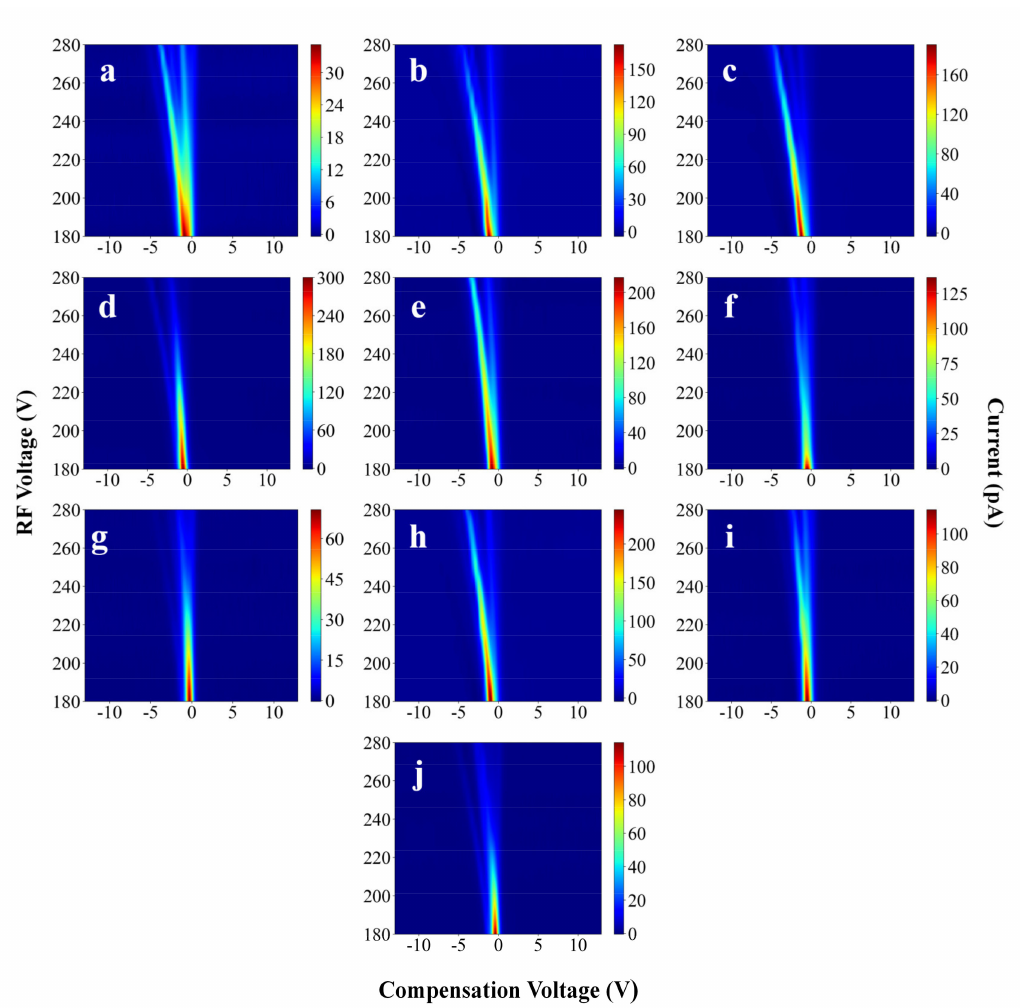
Figure 4. FAIMS spectra of several mixtures: ( a ) ethanol + ethyl acetate, ( b ) ethanol + acetone, ( c ) ethanol + acetone + ethyl acetate, ( d ) acetone + ethyl acetate, ( e ) ethanol + 4-methyl-2-pentanone, ( f ) ethanol + 4-methyl-2-pentanone + ethyl acetate, ( g ) 4-methyl-2-pentanone + ethyl acetate, ( h ) ethanol + 2-butanone, ( i ) ethanol + 2-butanone + ethyl acetate, and ( j ) 2-butanone + ethyl